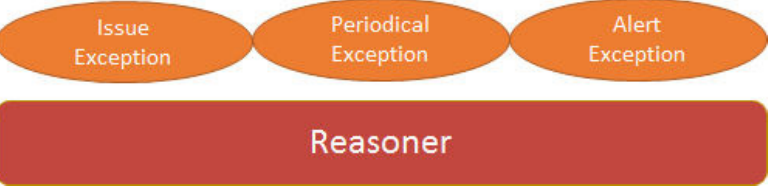
Figure 20. Possible issue notifications by the reasoner.